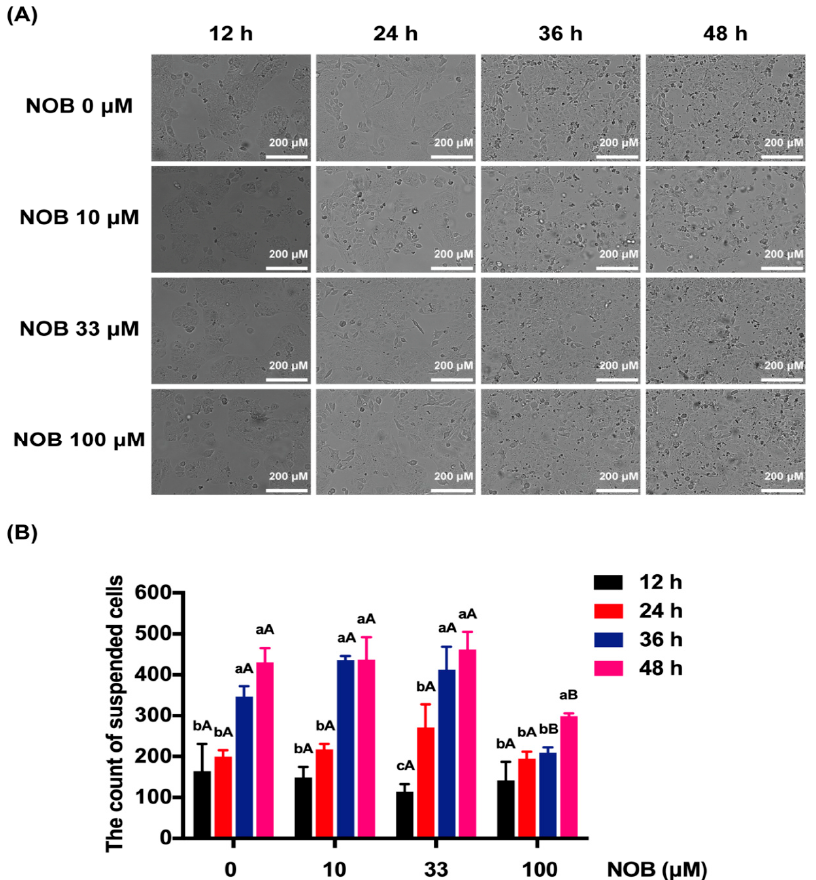
Figure 2. The e ff ect of NOB on cell morphology. ( A ) The morphology of BeWo cells. ( B ) The count of suspended cells. Data were summarized as mean ± SD, n = three independent experiments. At the same NOB treatment dose, di ff erent lowercase letters represent significant di ff erences at di ff erent treatment times, p < 0.05. At the same treatment time, di ff erent capital letters represent significant di ff erences at di ff erent NOB doses, p < 0.05, one-way ANOVA, with Duncan’s multiple range